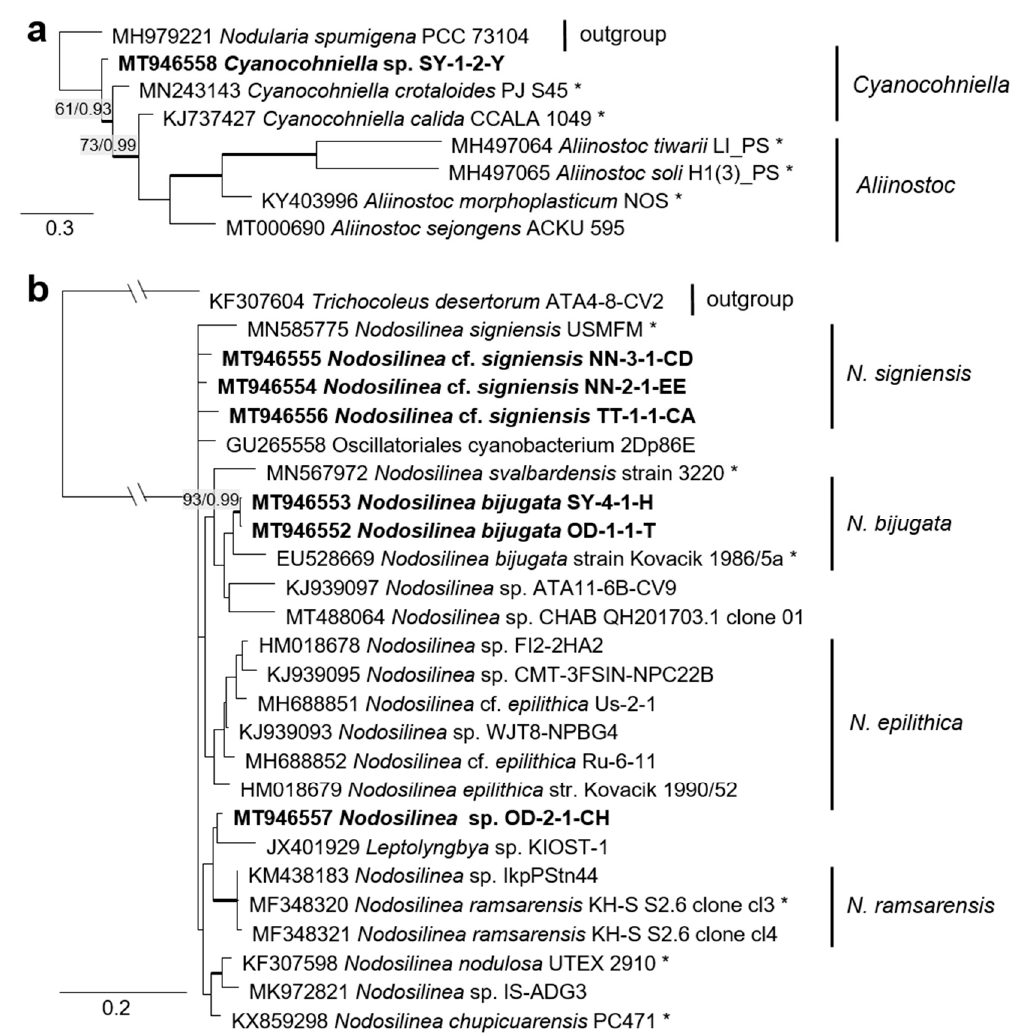
Figure 11. Molecular phylogeny of selected genera of the cyanobacteria. ( a ) Cyanocohniella based on SSU-LSU ITS sequencing and ( b ) Nodosilinea based on combined SSU and SSU-LSU ITS sequencing. The phylogenetic tree was calculated by the Bayesian method, including posterior probabilities (PP) with additional maximum likelihood bootstrap values (BP); branches are supported by both methods in bold (BP > 60% and PP > 0.9). Authentic strains marked with an asterisk, original strains of this study in bold.